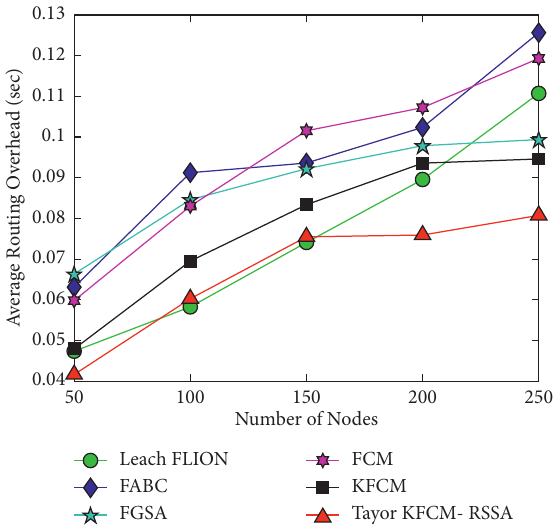
Figure 12: The value of mean square error predicted by C-means clustering algorithm.